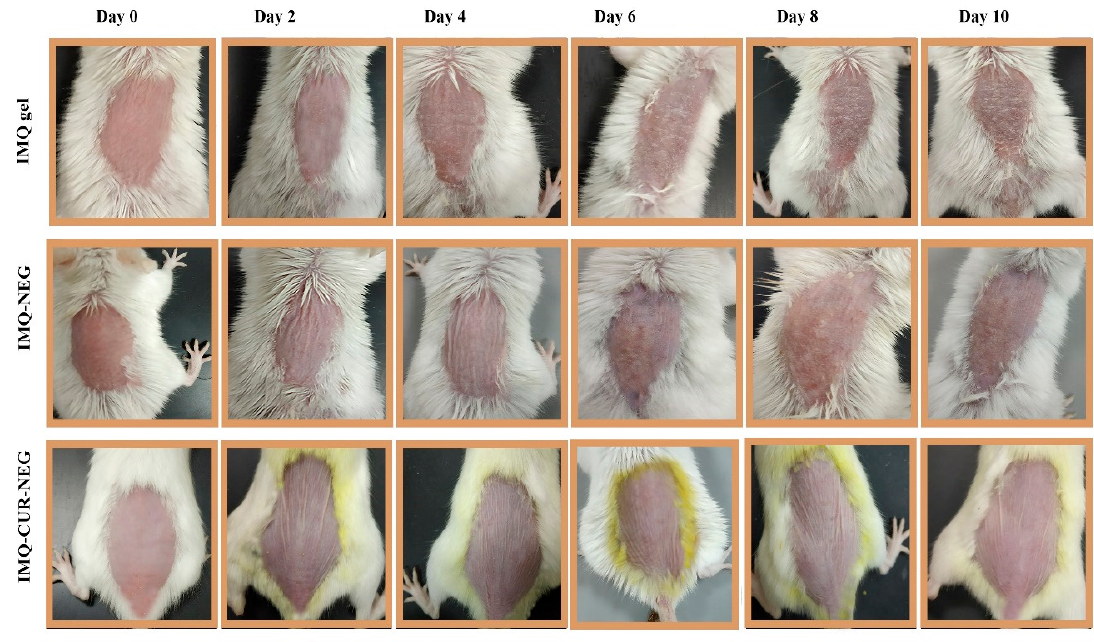
Figure 7. Assessment of psoriasis-like symptoms after the topical application of IMQ gel, IMQ-NEG, and IMQ-CUR-NEG for ten days.